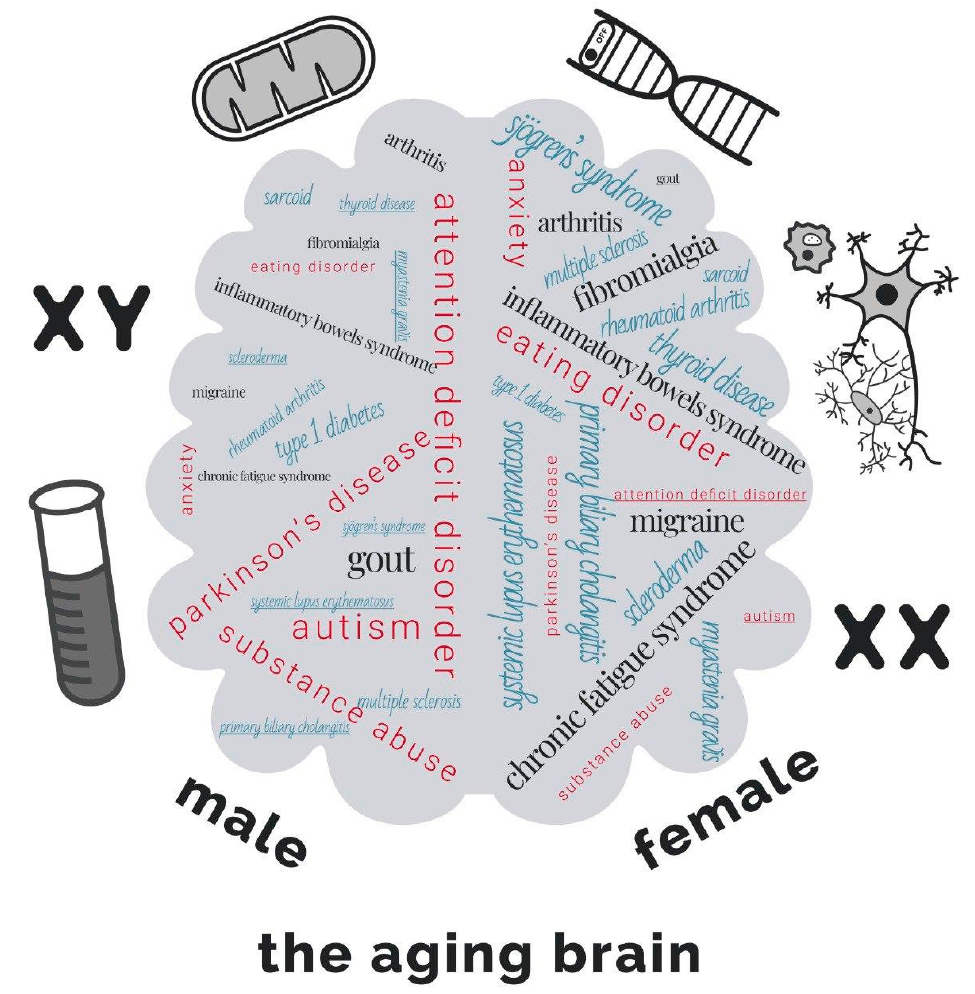
Figure 1. Sex differences in the incidence of diseases in men and women. The font size on a gray background correlates with the % of the incidence of the disease in a given sex [3]. Neurodegenerative or psychiatric diseases are shown in red font, autoimmune diseases are shown in blue font, and pain and social disabling disorders are shown in black font. An underlined font (e.g., male: Sjogren’s syndrome) corresponds to 5%, and the largest font (e.g., male: Myasthenia gravis) corresponds to 25%.